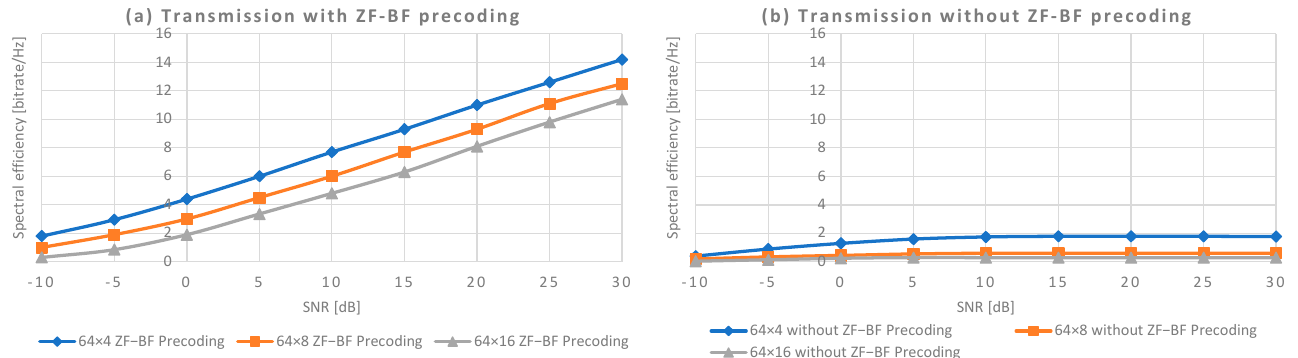
Figure 5. Impact of the number of users (mobile devices) into the spectral efficiency: ( a ) transmission with ZF-BF precoding; ( b ) transmission without ZF-BF precoding.